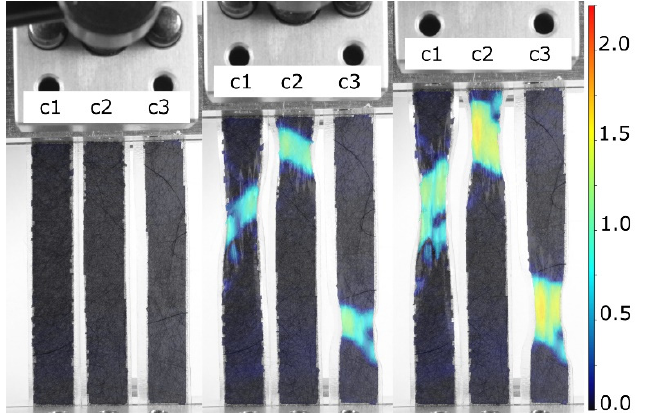
Figure 11. DIC y ‐ axial Hencky strain analyses of the elongation of laminated CFC samples, where the c1 sample had 1 thin CFC, the c2 sample had 2 thin CFCs, and the c3 sample had 3 thin CFCs between the transparent TPU films. The deformation was mostly localized in the failure locations, whereas the rest of the sample exhibited almost no deformation under the load. The scale bar shows the level of local deformations compared to the initial undeformed phase of the